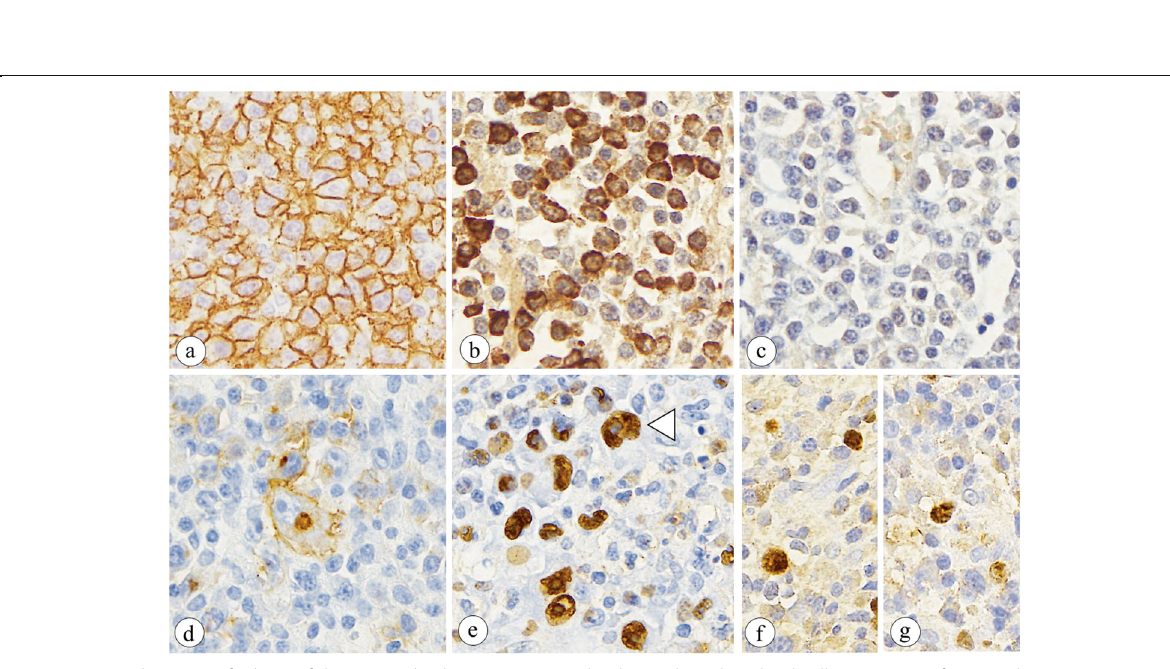
Fig. 3 Immunophenotypic findings of the resected colon: Large, atypical polymorphous lymphoid cells are positive for CD20 by immunohistochemistry ( a ) , positive for the κ -light chain ( b ) and negative for λ -light chain ( c ) by in situ hybridization (ISH). Hodgkin-like cells are positive for CD30 by immunohistochemistry ( d ) and Epstein-Barr encoding region (EBER)-1 ( e , Arrowhead) by ISH. Some large, atypical lymphoid cells also are positive for EBER-1 ( e ) by ISH. In a retrospective analysis, EBER-1-positive large atypical cells are present on the 9-day and 3-week colorectal tissue sections ( f & g